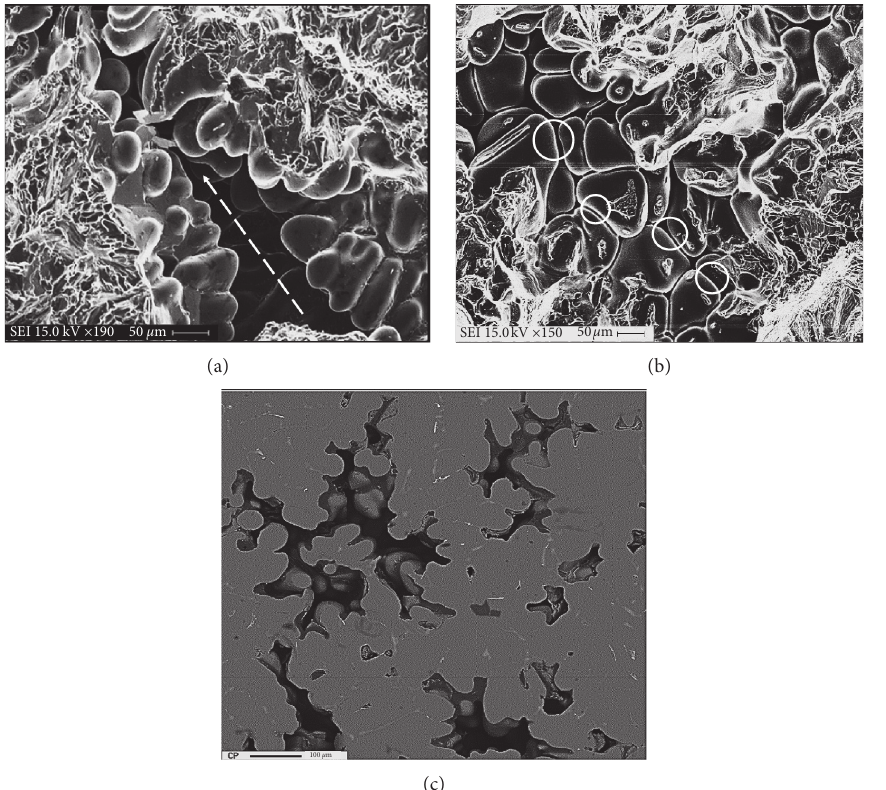
Figure 10: Formation of shrinkage cavities in Sr-modified A356 alloy: (a) tensile test bar ( H ( H 2 =0.4 ml/100g Al), (c) sand casting of non-modified A356 alloy ( H 2 < 0.1 ml/100g Al), average dendrite arm spacing is ∼ 120 μ m.